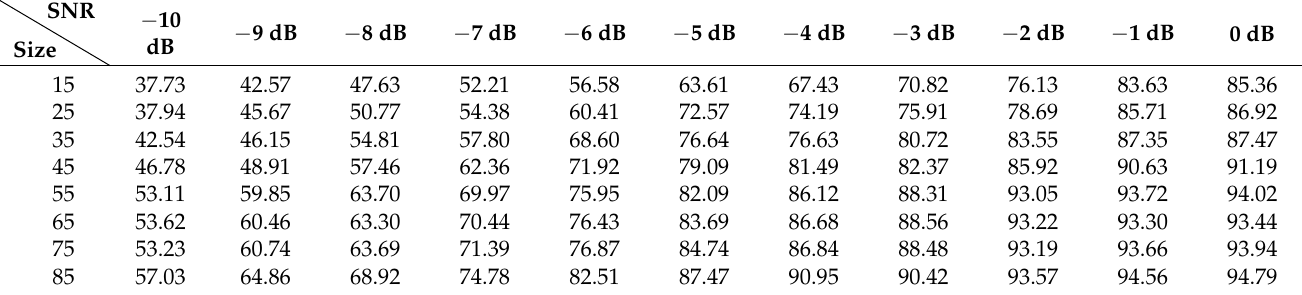
Table 9. Classification performance of the CL–CNN model in varying sample sizes for each class and